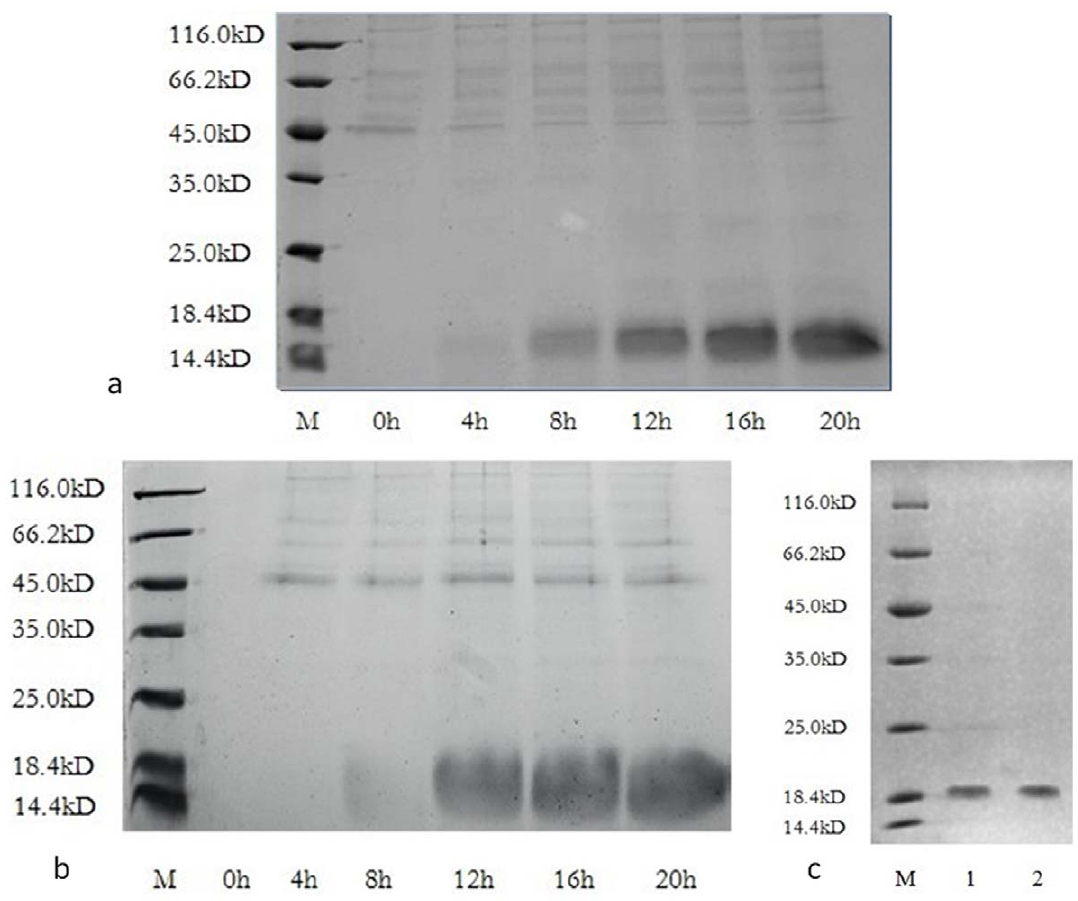
Figure 1. Expression and purification of unlabeled RGD-hirudin and labeled RGD-hirudin were analyzed by 15% SDS-PAGE. Lane M, molecular mass standards (116 to 14.4 kDa ). a. Loading was 10 m L of culture supernatant of unlabeled RGD-hirudin for 0 to 20 h after methanol induction. b. Loading was 10 m L of culture supernatant of labeled RGD-hirudin for 0 to 20 h after methanol induction. c. Loading was 10 m L of the purified unlabeled RGD-hirudin (Lane 1) and labeled RGD-hirudin (Lane 2).